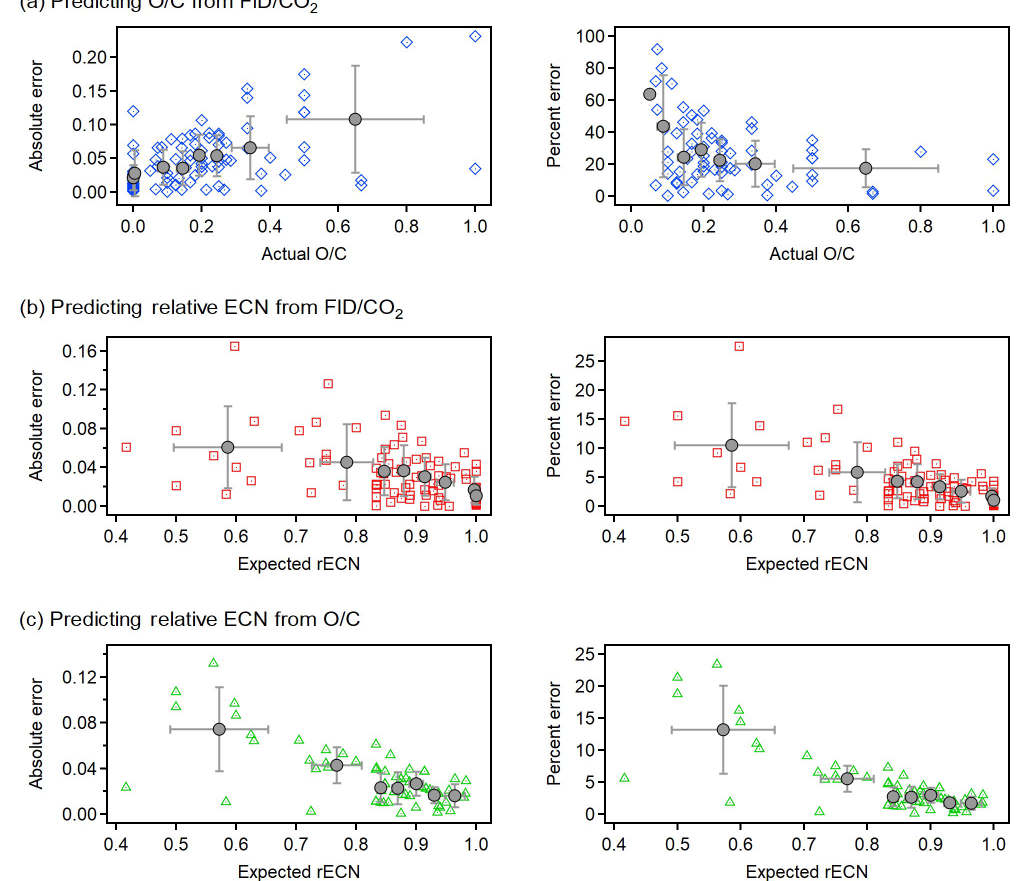
Figure 6. Absolute error (left panels) and relative error (right panels) in the prediction of (a) O / C from FID / CO 2 , (b) rECN from FID / CO 2 , and (c) rECN from O / C. All errors shown against the actual value of the predicted value (i.e., compound O / C or rECN estimated from structure–activity relationships). Relative error calculated as | observed − actual | / actual × 100%. All analyzed compounds ( N = 89) shown as individual points with the same colors and shapes as in Fig. 3. To make trends more qualitatively clear quantiles of an equal number of points are shown in gray (quantile average with standard deviation as error